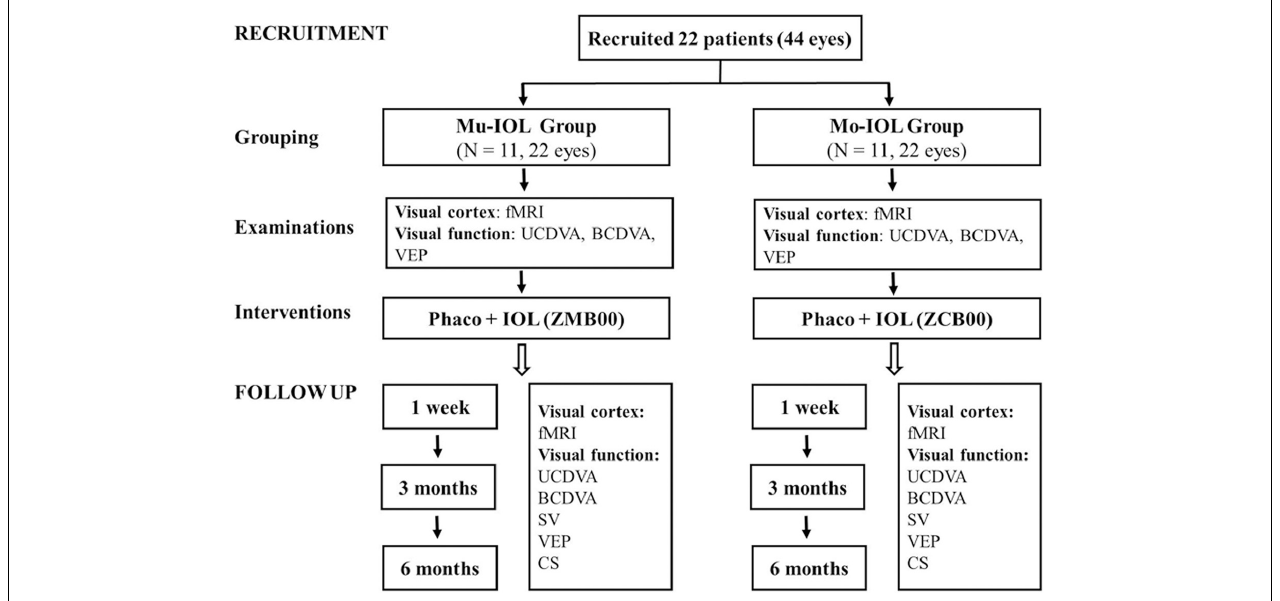
FIGURE 1 | Flowchart of recruitment and follow-up evaluations. fMRI, functional magnetic resonance imaging; UCDVA, uncorrected distance visual acuity; BCDVA, best-corrected distance visual acuity; CS, contrast sensitivity; SV, straylight values; VEP, visual evoked potential; Mo-IOL, monofocal intraocular lens; Mu-IOL, multifocal intraocular